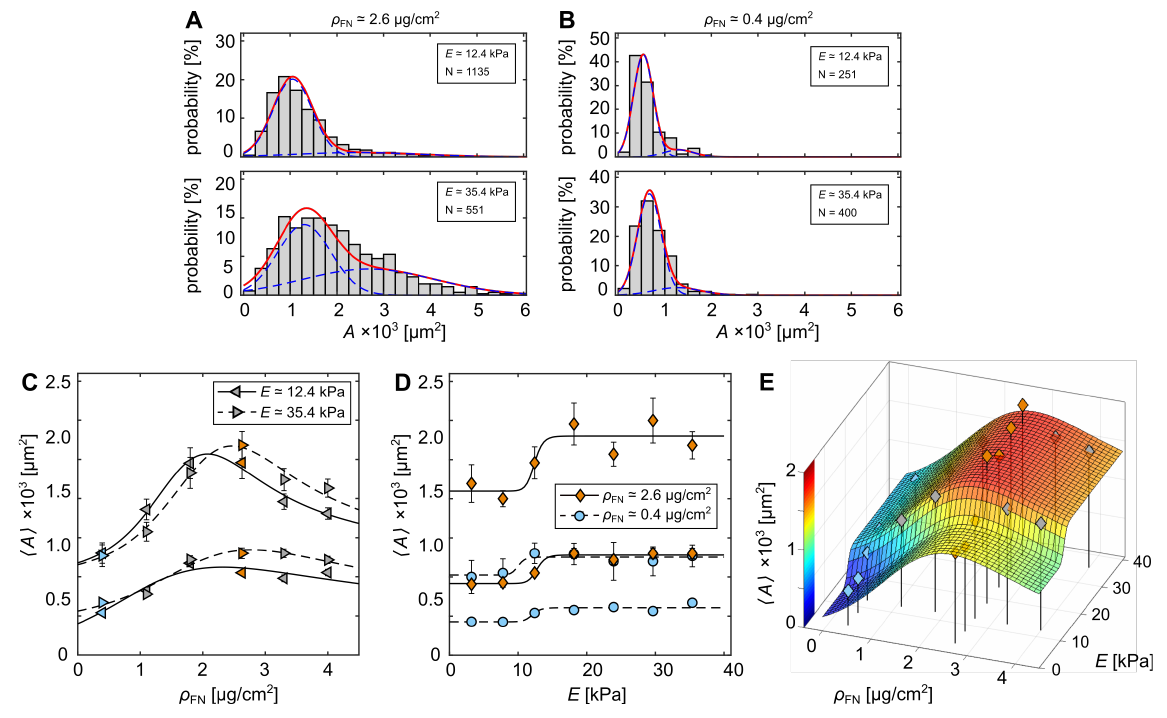
Figure 4. Cross-talk between hydrogel rigidity and fibronectin density. ( A , B ) Example of area distributions fitted by the mixture of two normal probability density functions (MN-pdf, see Supplemental Material). Red lines are MN-pdf, and blue lines are the two individual normal distribu- tions. ( C ) Lower and higher means (cid:104) A (cid:105) of the obtained MN-pdfs as a function of ρ FN at E (cid:39) 12.4 kPa (left pointed triangles) and E (cid:39) 35.4 kPa (right pointed triangles). Solid and dashed lines are fits of the Lorentz equation (Equation (5)) for the two Young’s moduli. The data correspond to the data shown in Figure 3E. ( D ) Lower and higher means (cid:104) A (cid:105) of the obtained MN-pdfs as a function of E for ρ FN (cid:39) 0.4 µ g/cm 2 (blue circles) and ρ FN (cid:39) 2.6 µ g/cm 2 (orange diamonds). Solid and dashed